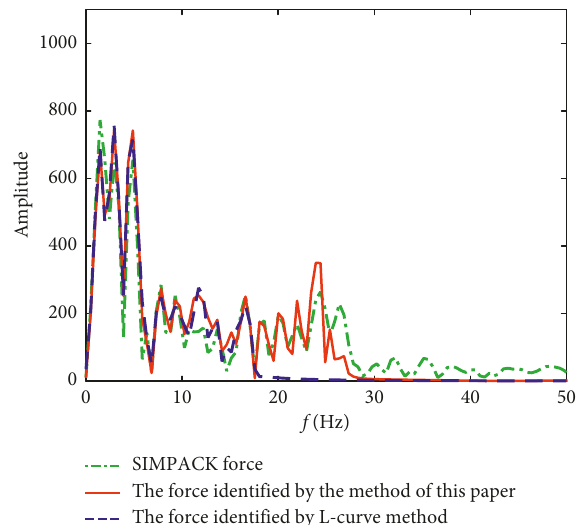
Figure 12: Amplitude-frequency curve of the two methods for F identification when the noise level is 5%. 4